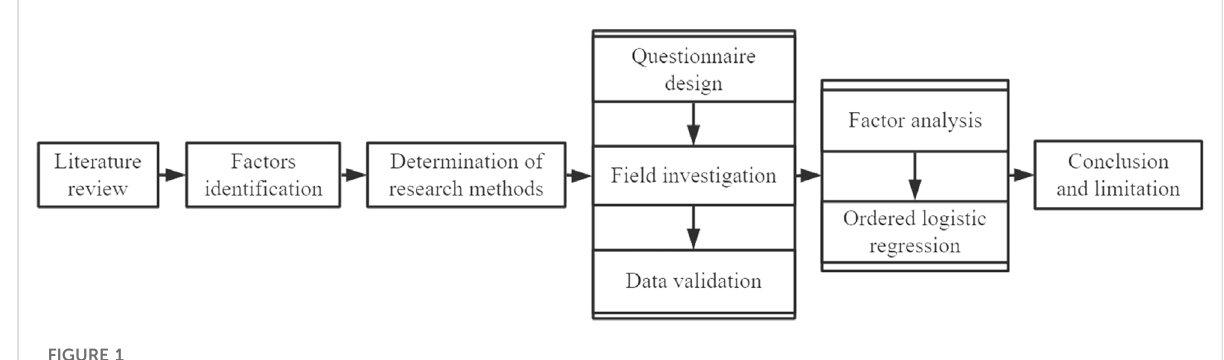
FIGURE 1 Technology